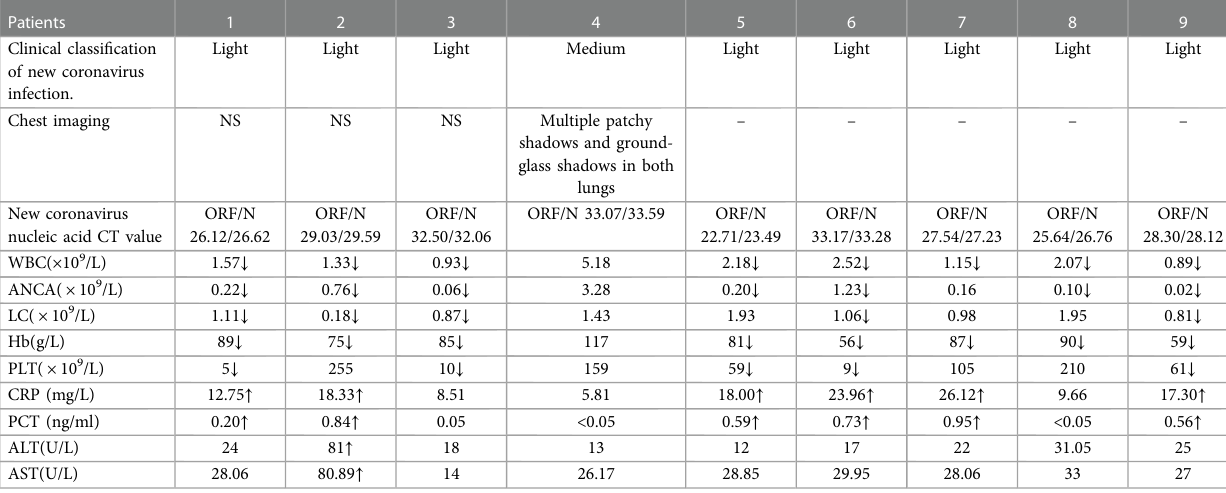
New coronavirus nucleic acid CT value